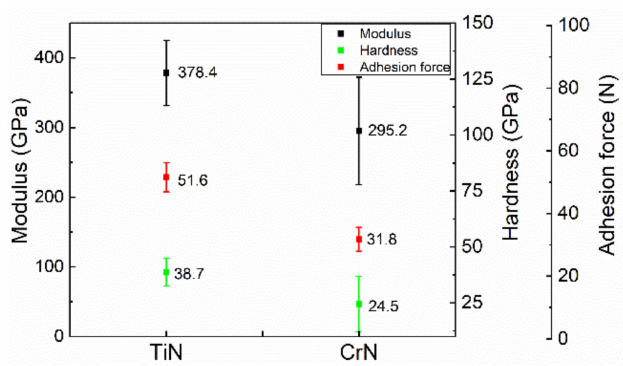
Figure 7. Elastic modulus, hardness and adhesion force of the CrN coating and TiN coating.